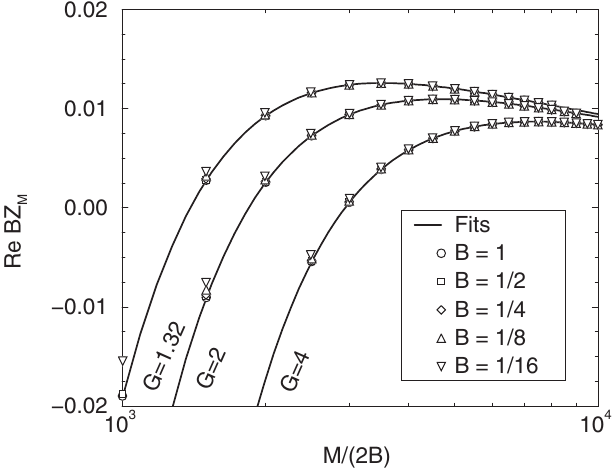
FIG. 3. Real part of resistive wall (cid:7) first order damper effec- tive